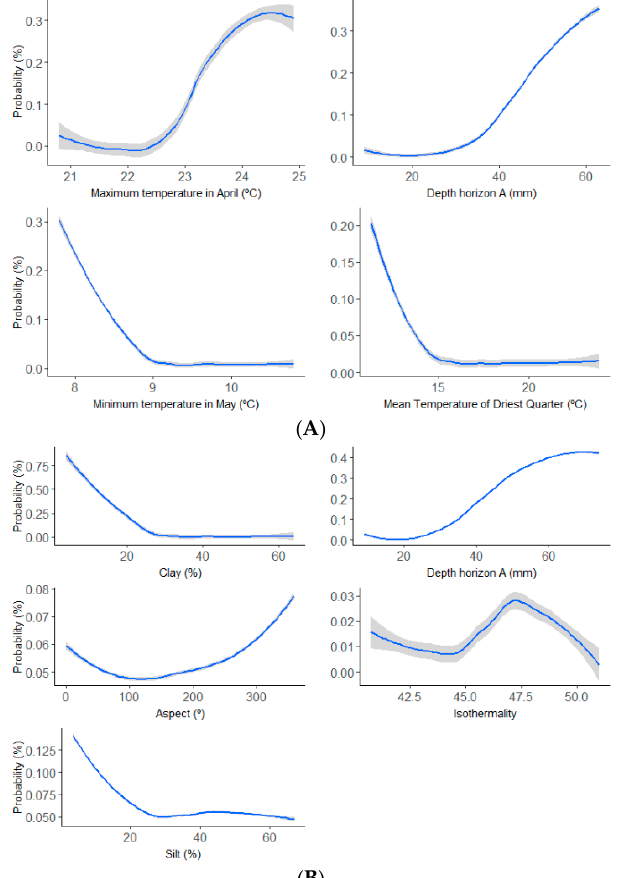
Figure 2. Response curves showing the average probability value of the ensemble model for each explanatory variable, for Eucalyptus dunnii ( A ) and E. grandis ( B ).